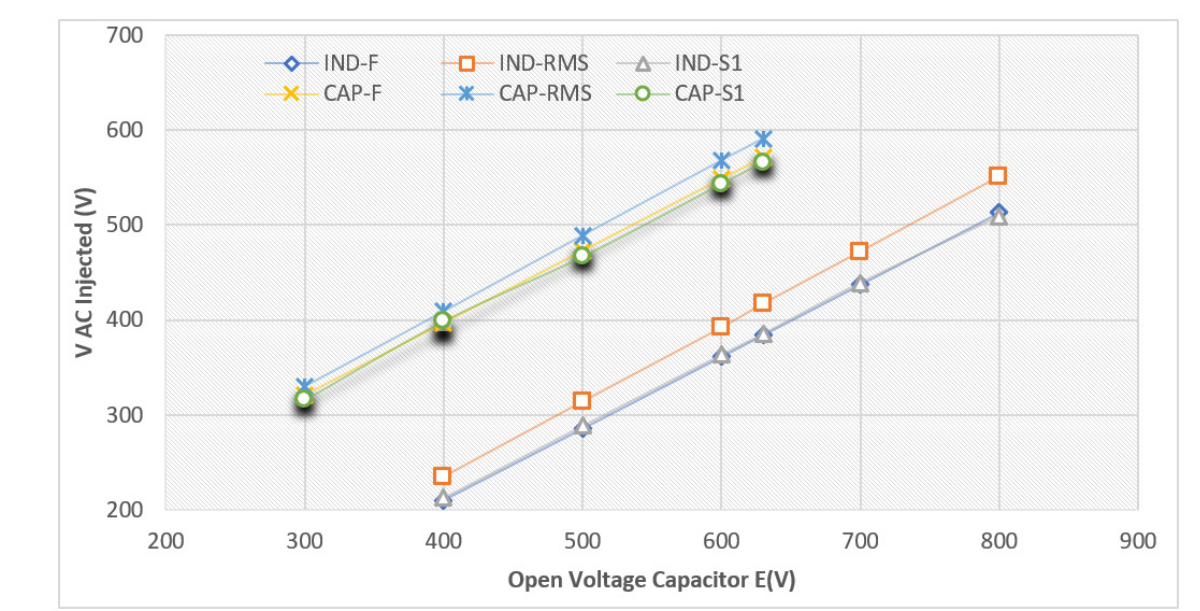
Figure 12. PSIM output voltage and current for ( a ) capacitive; and ( b ) inductive injection mode.